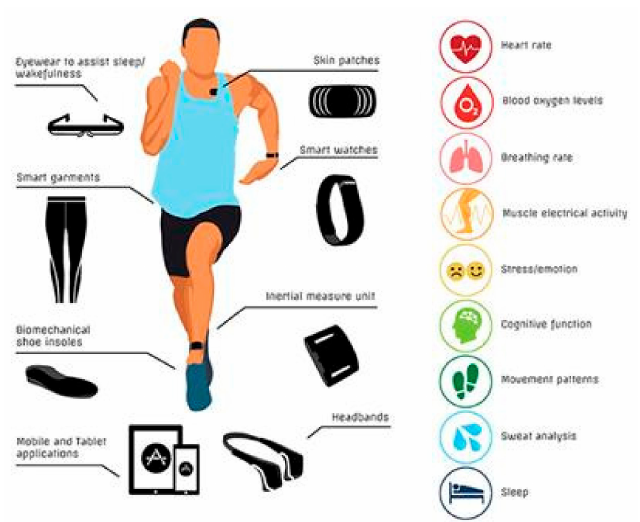
Figure 11. Summary of current technologies for monitoring health / performance and targeted physical measurements [156].